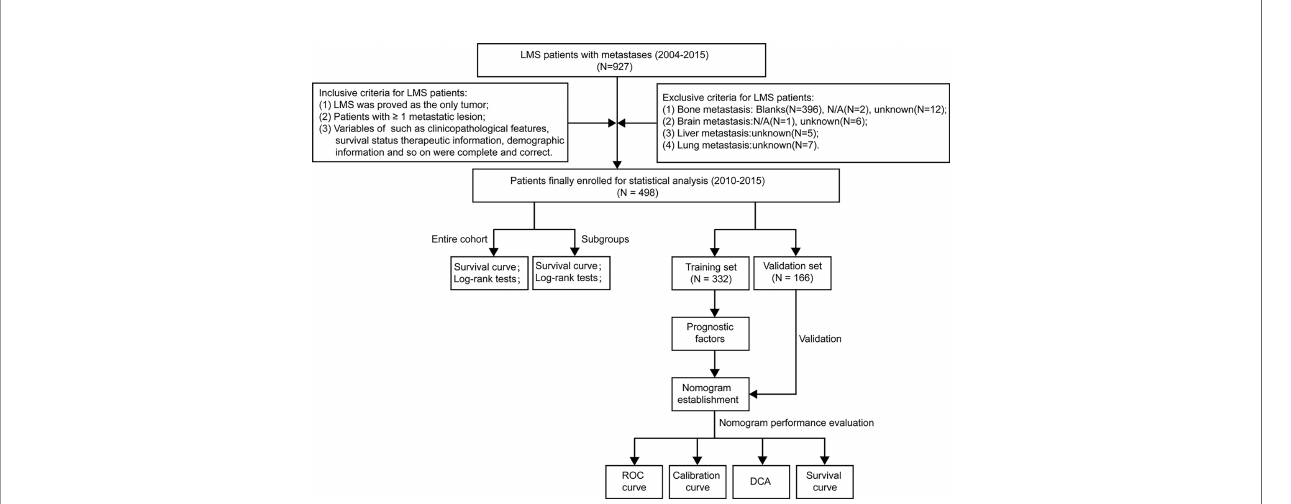
FIGURE 1 | The fl owchart describing the process of conducting the study and statistical analysis. ROC, receiver operating characteristic; DCA, decision curve analysis; LMS,